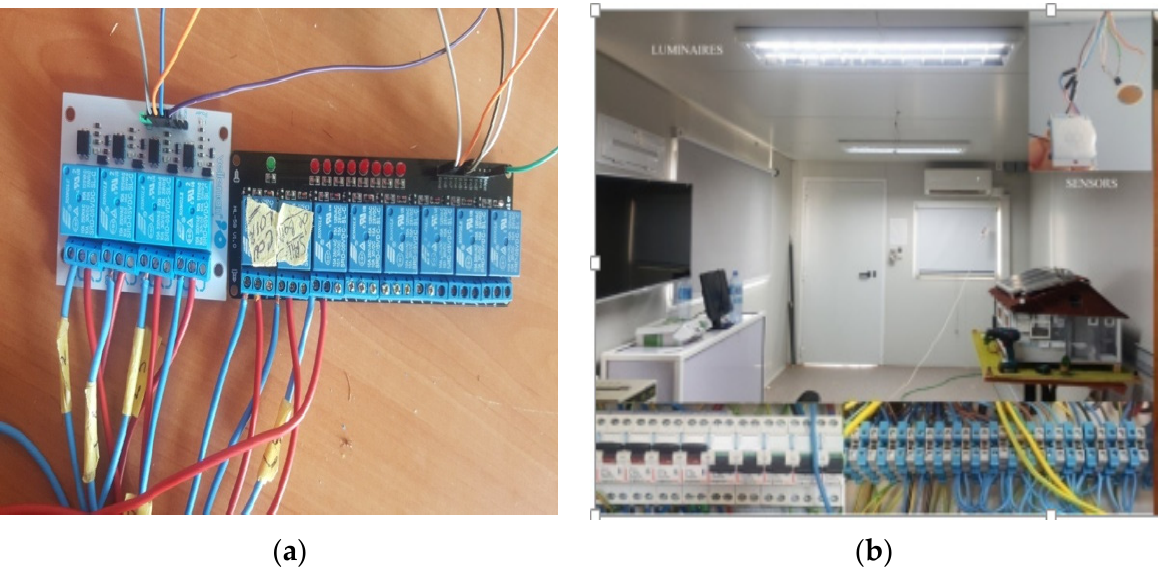
Figure 17. Implementation of the proposed automatic lighting control in solar house: ( a ) relays and ( b ) luminaires turned on when the conditions are satisfied.